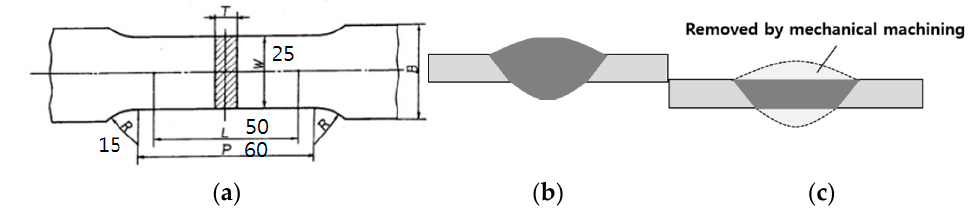
Figure 3. Schematic diagrams of prepared tensile test specimen (all dimensions in mm). ( a ) X ‐ Y plane; ( b ) X ‐ Z plane section with reinforcement; ( c ) X ‐ Z plane section without reinforcement.